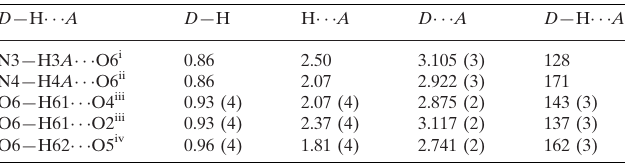
Hydrogen-bond geometry (A˚ , (cid:3)